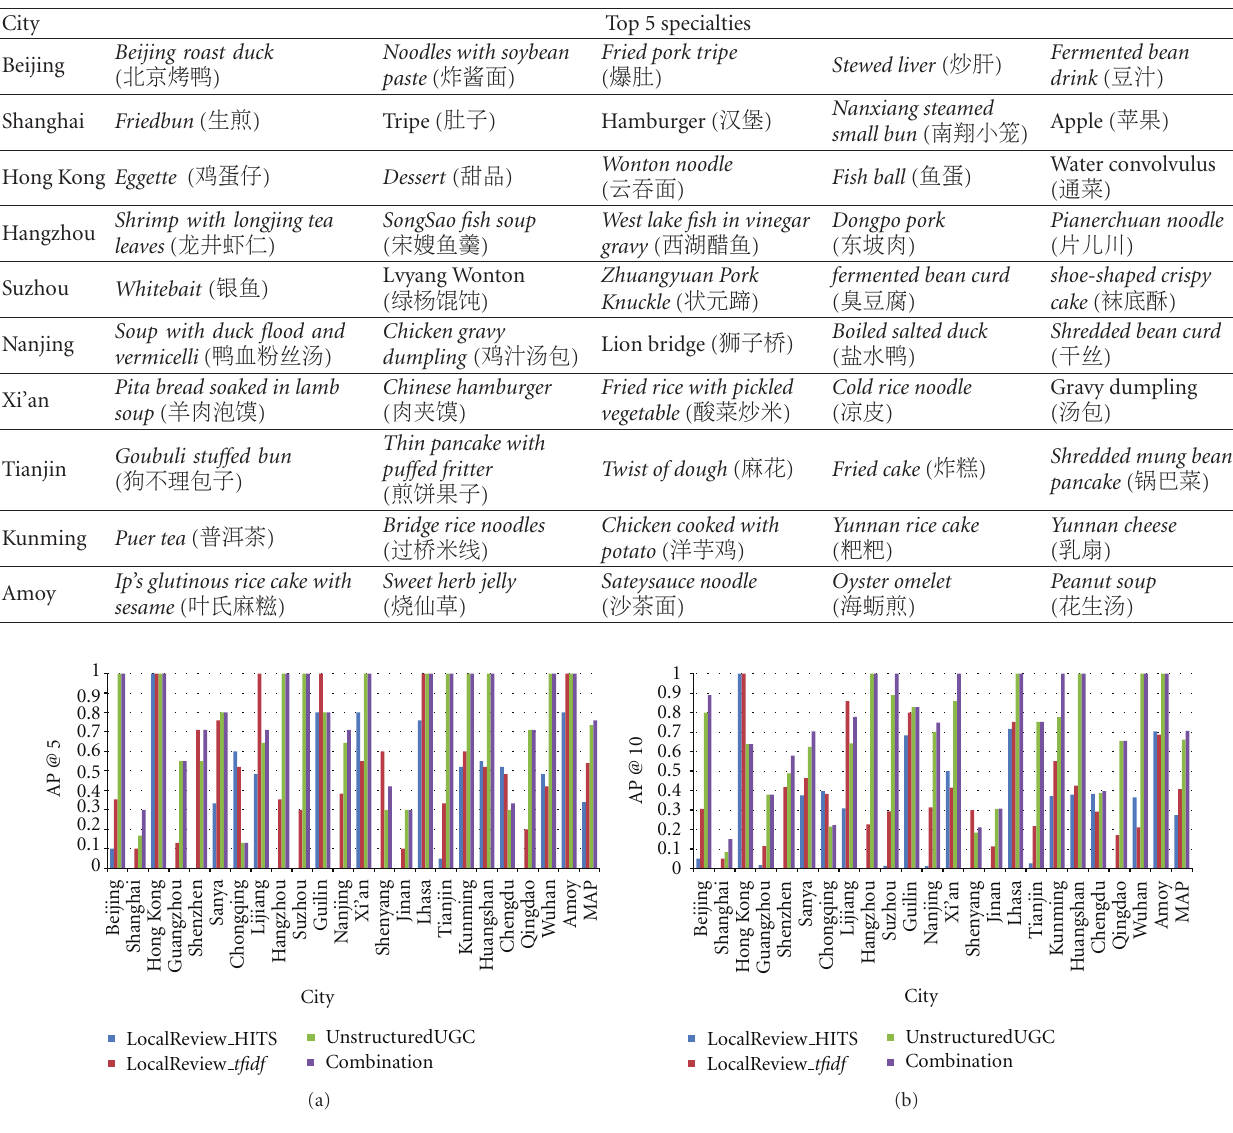
Table 2: Examples of mined cities’ specialties. The italic dish names are the correct ones.